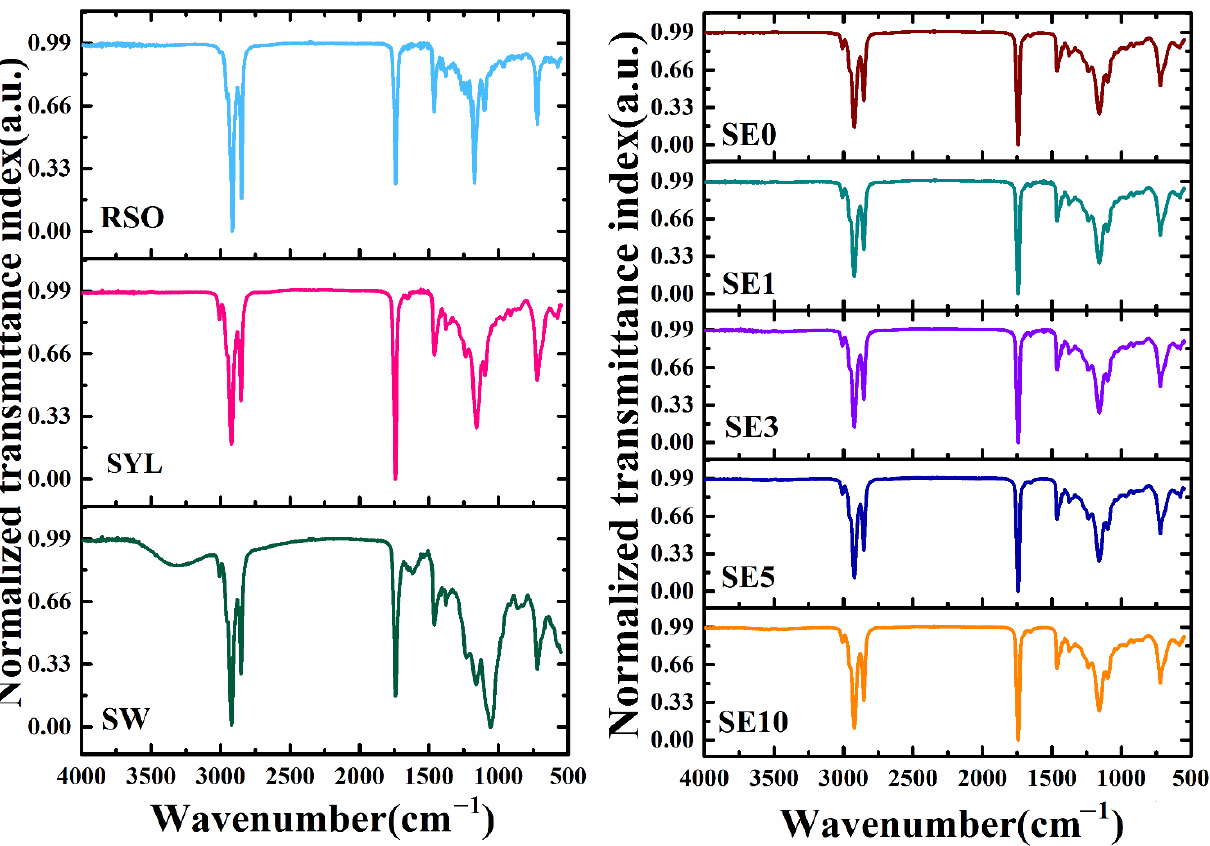
Figure 5. FTIR spectra of the raw materials and oleogels.